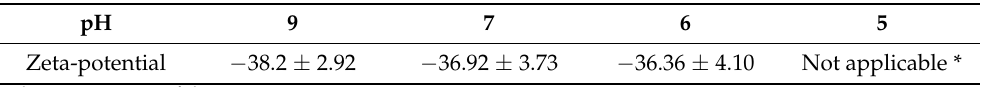
Table 2. The values of zeta-potential of the PNIPAM-PAA- β -FeO(OH) microgel at different pH values. pH 9 Zeta-potential − 38.2 ± 2.92